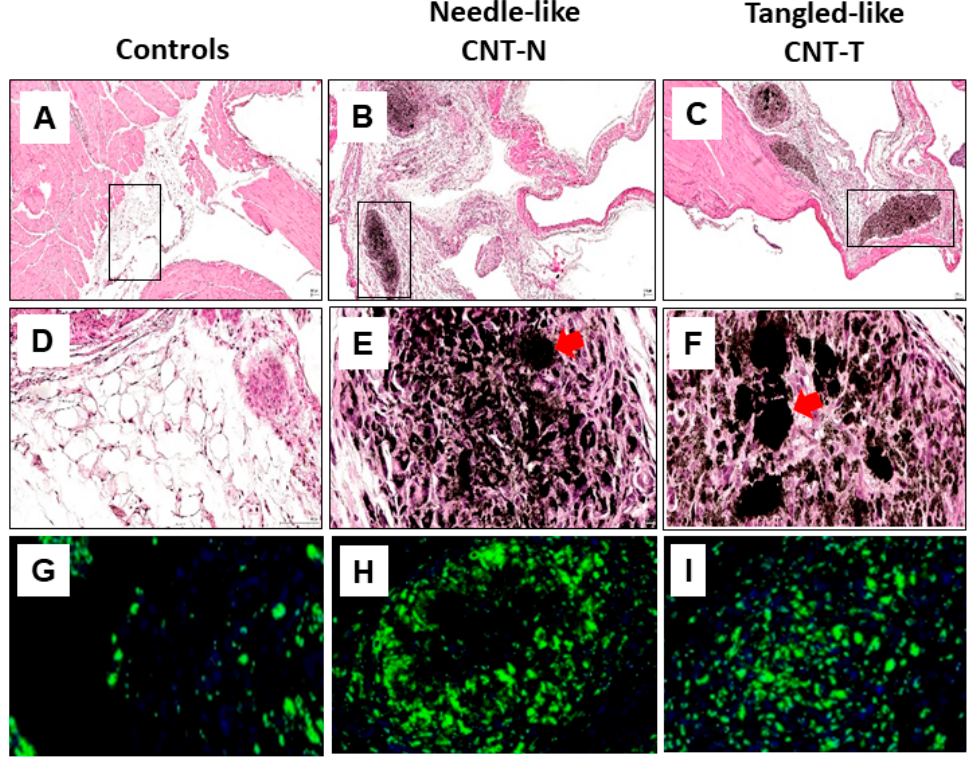
Figure 3. Mesotheliomagenic CNT-N and non-mesotheliomagenic CNT-T induce early comparable peritoneal lesions and macrophage accumulation in rats. Wistar rats untreated or injected (i.p) with CNT-N or CNT-T (2 mg) were sacrificed (day 15) and peritoneal tissues (diaphragm) were harvested, fixed in paraformaldehyde and embedded in para ffi n. 5 µ m sections were stained with classical H&E coloration ( A - D - G for controls, B - E - H for CNT-N and C - F - I for CNT-T, magnification × 4 first line, × 40 other lines). The red arrows indicate granulomas containing CNT crystalline structures within the connective tissue (selected from the frame of A - B - C panels). Granulomas mainly comprise macrophages around nanotube aggregates ( G - H - I ). For macrophage identification, 5 µ m sections were incubated with mouse anti-rat CD68 antibody (Abcam monoclonal) and secondary antibody donkey anti-mouse (Jackson ImmunoReserch) coupled with HRP. After incubation with AlexaFluor Tyramide 488, a counterstaining with Hoechst44432 dye was performed. Stained slides were digitalized using a Panoramic 250 FlashIII scanner (3DHistech) at × 20